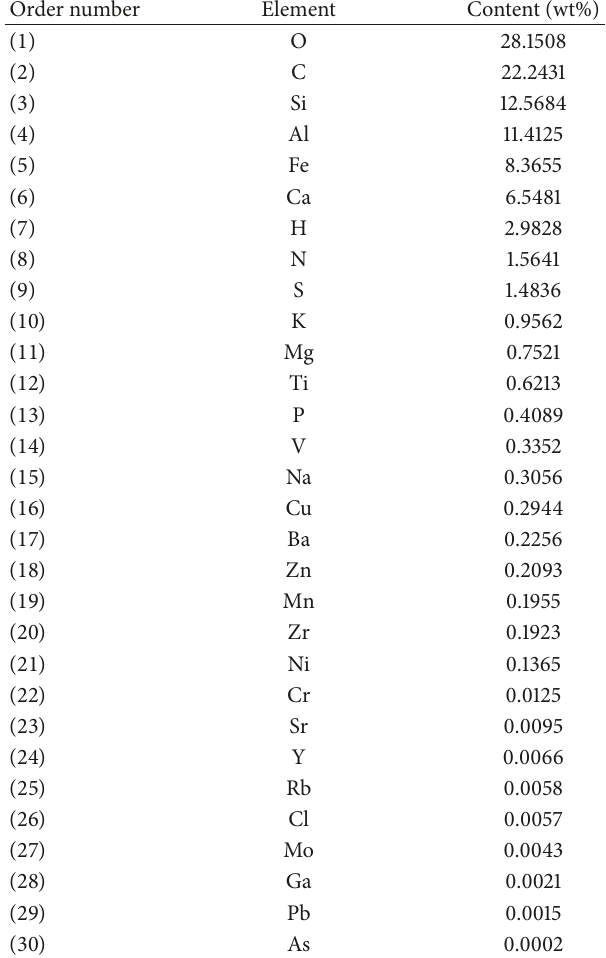
Table 1: Ultimate analysis of the raw sediment.